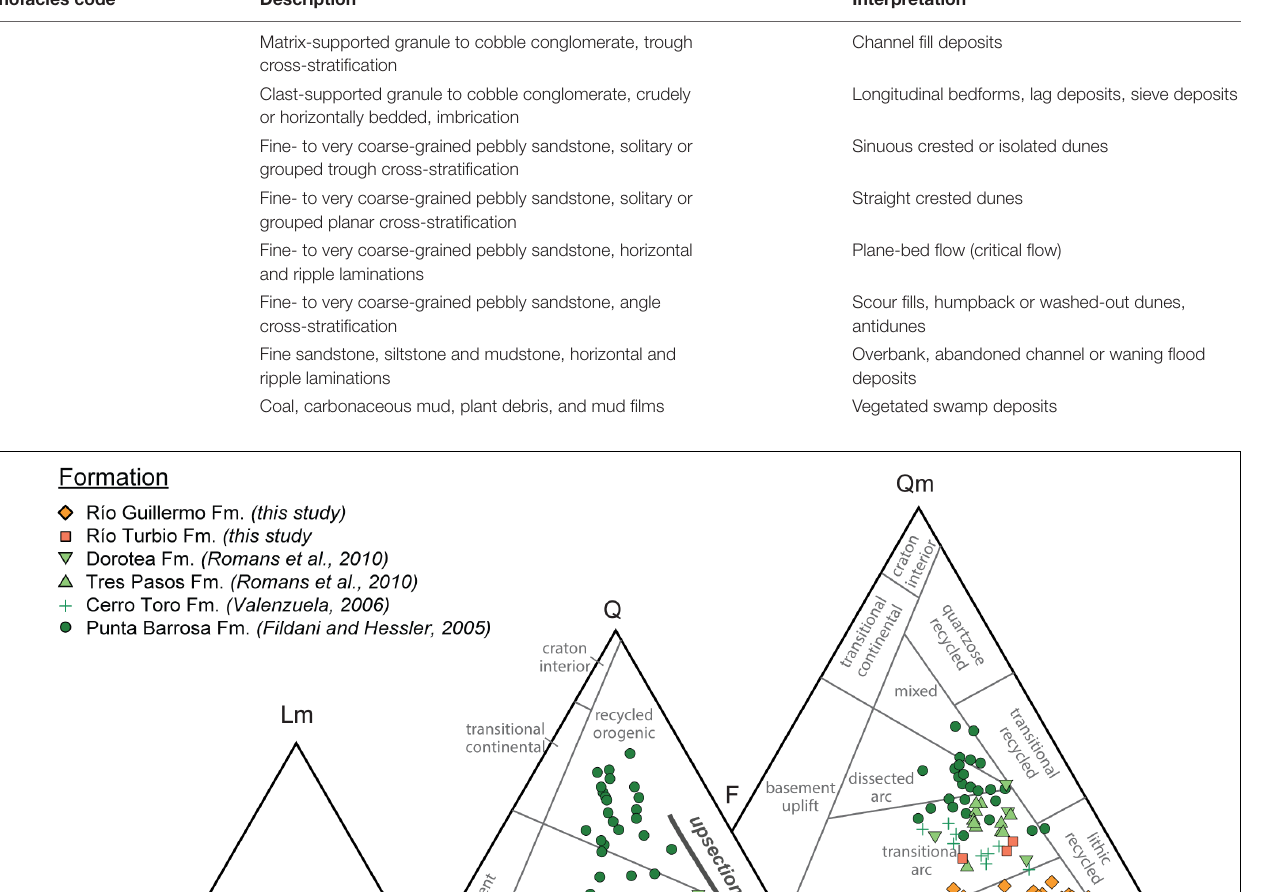
TABLE 2 | Lithofacies codes, sedimentary structures, and interpretations used in this study (modified after Miall, 1978). Lithofacies code